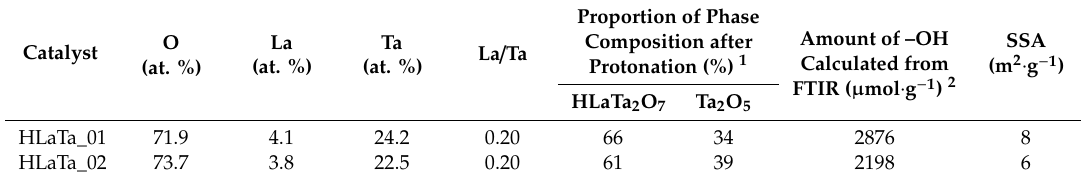
Table 3. Surface composition (in at. %), amount of hydroxyl groups and specific surface area of HLaTa_01(02) protonated layered perovskites. Proportion of Phase Composition after La Ta O Catalyst La / Ta Protonation (%) (at. %) (at. %) (at. %)